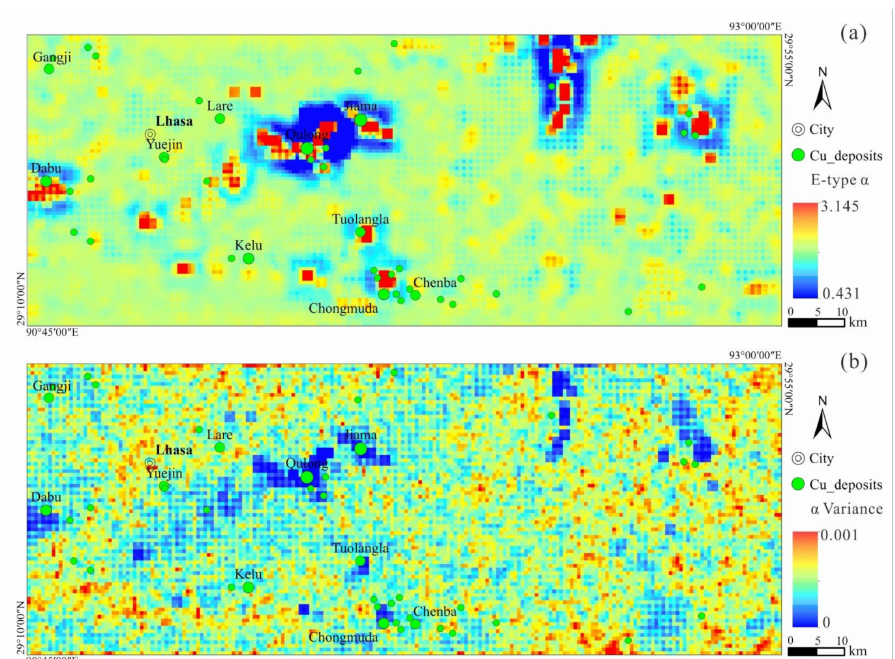
Figure 9. ( a ) The E-type α map and ( b ) the α variance map.